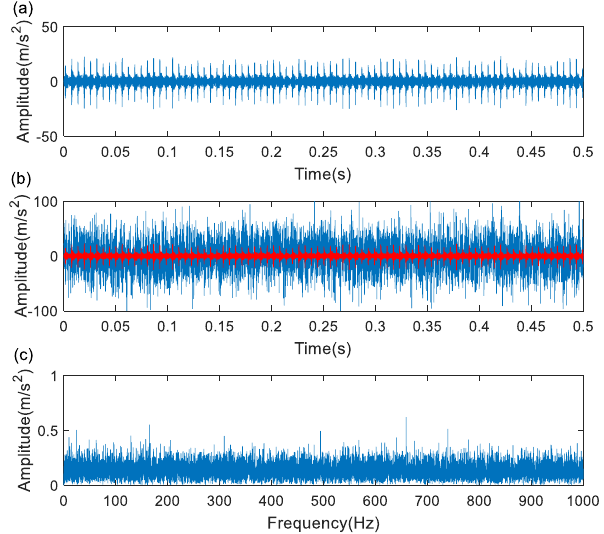
Figure 15. The outer ring fault signal: ( a ) original signal; ( b ) noisy signal; ( c ) envelope spectrum.